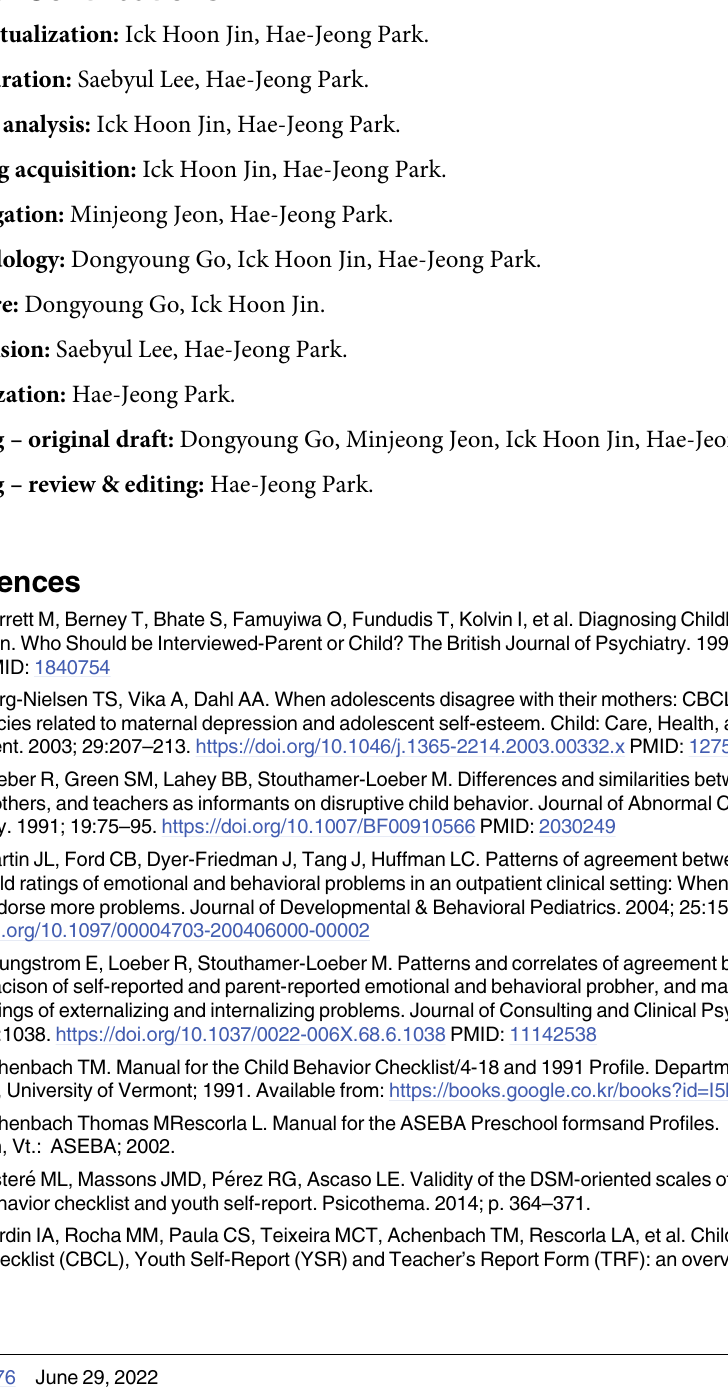
S1 Table. Items’ syndrome membership. S2 Table. Factor structures for CBCL and